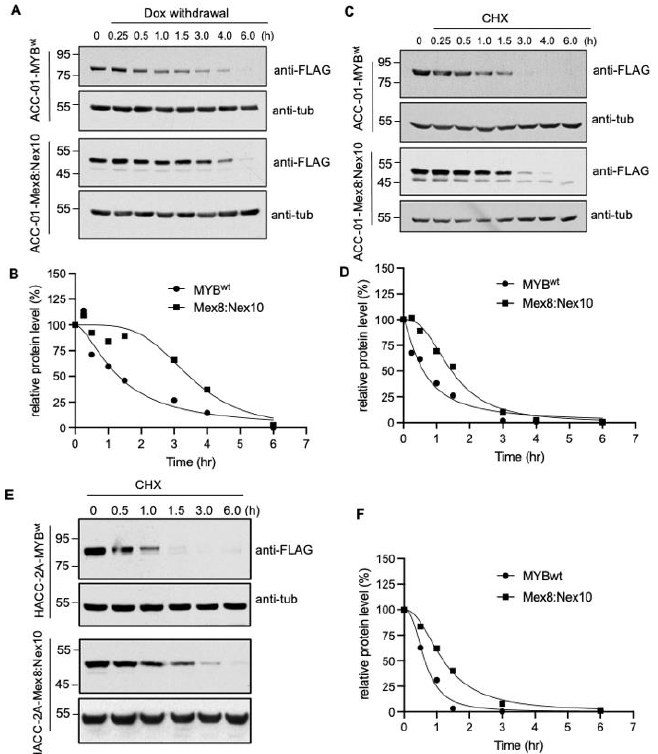
Figure 4. Differential protein stability of MYB wt and MYB-NFIB fusion. ( A , B ), Stable ACC-01 cells harboring FLAG-tagged MYB wt or MYB-NFIB fusion were dox-induced for 24 h, then re-cultured in media without dox for the indicated time period. Cell lysates were prepared and analyzed by Western blotting followed by densitometry to determine half-life of MYB wt and MYB-NFIB fusion. ( C , D ), Cells as above induced with dox for 24 h were treated with cycloheximide (CHX; 100 ug/mL) for the indicated time period. Cell lysates were prepared and subjected to immunoblotting and densitometric analysis. ( E , F ), HACC-2A cells expressing dox-induced FLAG-tagged MYB wt or MYB-NFIB fusion were incubated with CHX and analyzed as